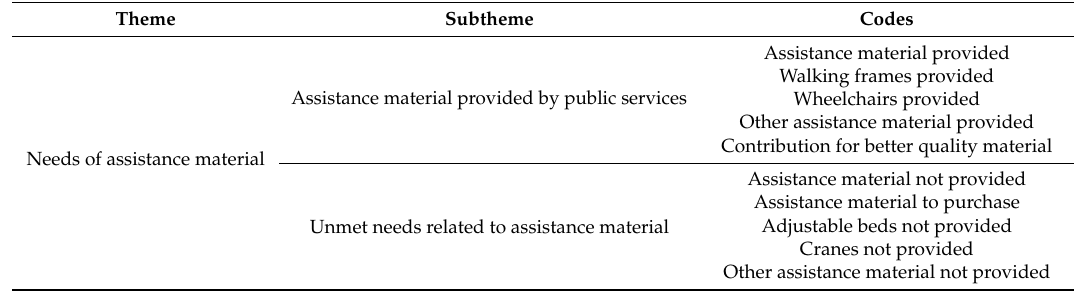
Table 3. Theme, subthemes, and codes related to the satisfaction of biological needs of